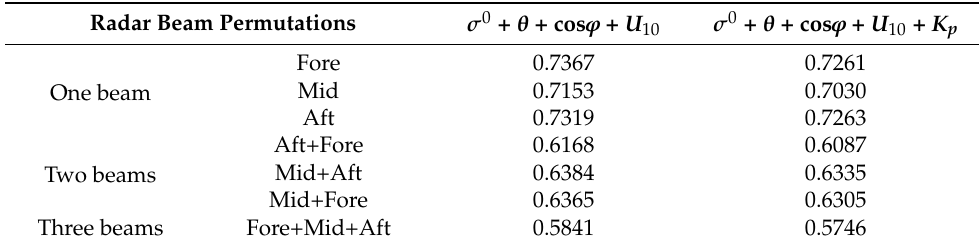
Table 2. Performance (root mean square error, unit: m) of deep learning model against validation set using different variables from